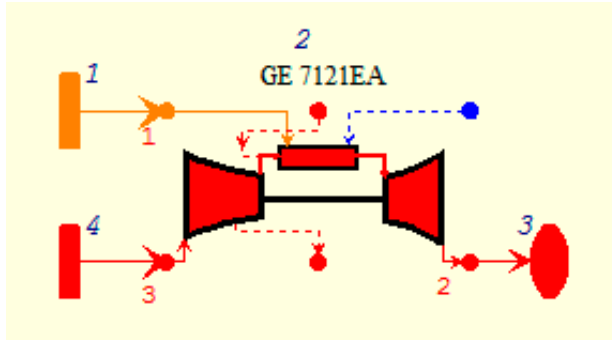
Figure 6. Thermoflex model of the GE 7001EA gas turbine. Table 2. Average weather conditions of Riyadh [31].